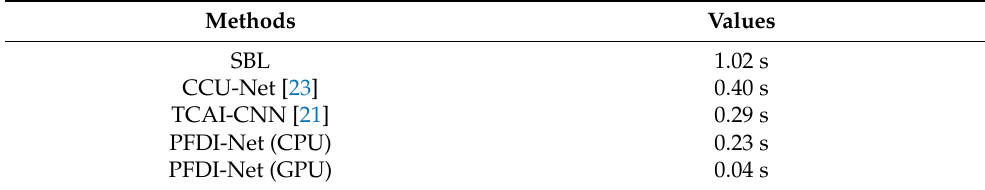
Table 2. Imaging runtime.